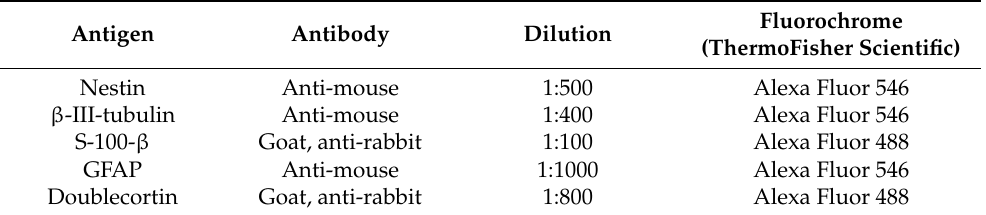
Table 4. List of secondary antibodies used for immunocytochemistry.